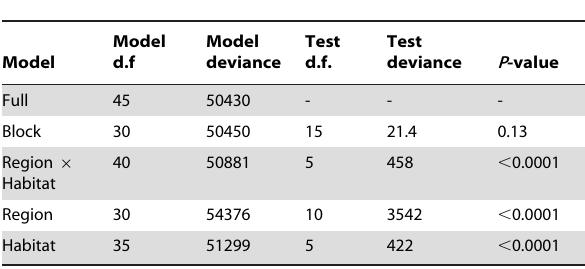
Table 1. Summary of aster model comparisons to test for effects of region and habitat on C. fasciculata lifetime seed